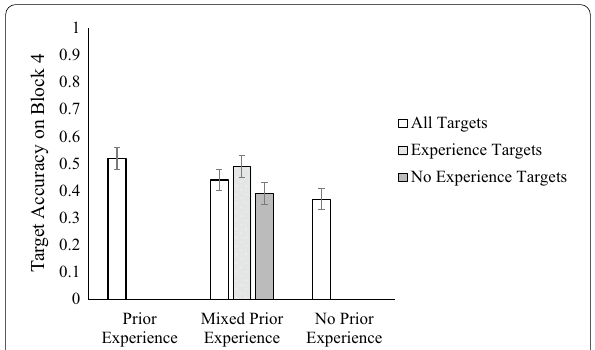
Fig. 4 Target accuracy by experience condition and category in the mixed experience condition